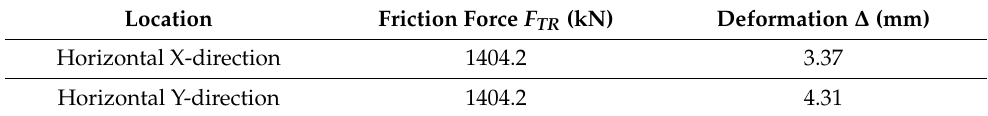
Table 8. Properties of horizontal link